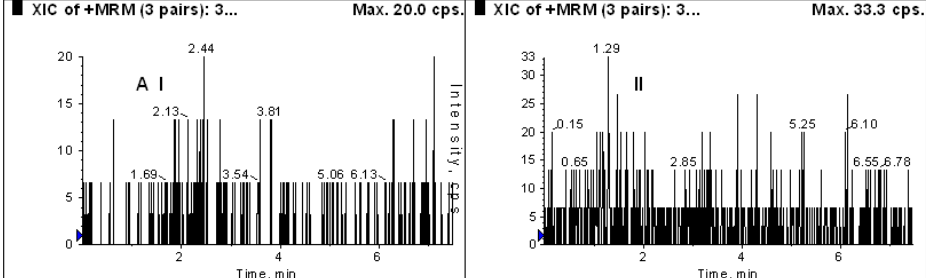
Figure 4. MRM chromatograms for ( A ) blank plasma, ( B ) plasma (200 μ L) spiked with 2.5 and 800 ng/mL IS; ( C ) plasma spiked with 100, and 800 ng/mL IS; and ( D ) a plasma sample 1 h after oral administration of 97.5 mg/kg DHC to a rat. I: DHC; II: